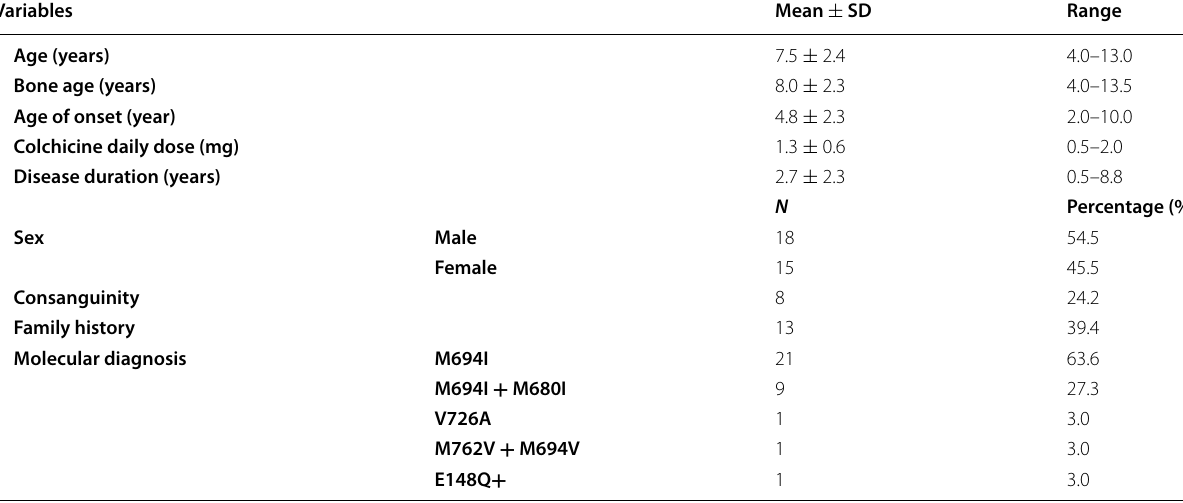
Total N 33 = Table 2 Effect of vitamin D administration on ZBMI, attack duration, OPG, and vitamin D Variables Before